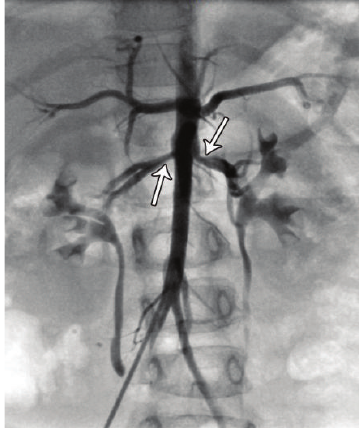
Figure 4: Angiography. Abdominal aorta injection: renal artery stenosis.